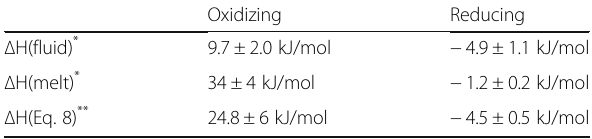
Table 1 Enthalpy of D/H fractionation in coexisting fluid and melt in silicate-COH under oxidizing and reducing conditions (data from Mysen